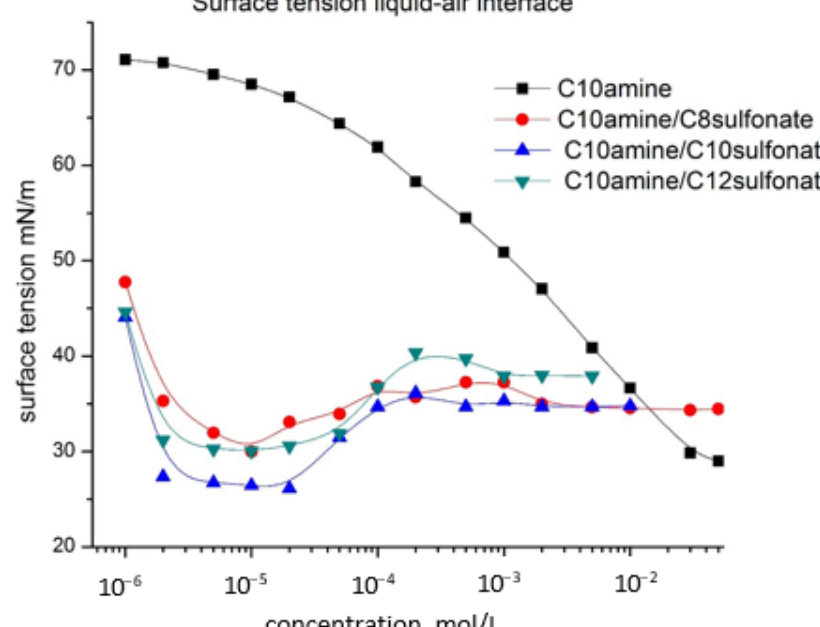
Figure 1. Measured surface tension vs. surfactant concentration for different systems at liquid–air surface [55]. Reprinted from Ref. [55] with permission. Copyright Elsevier 2009.